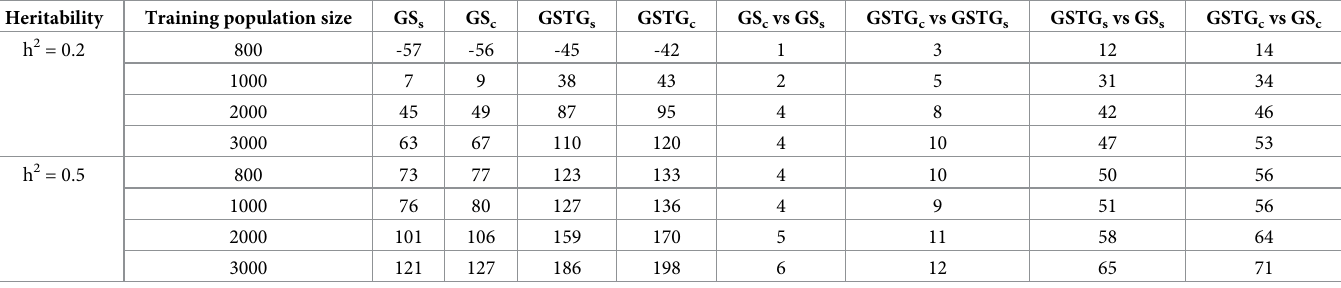
Table 7. Additional genetic gains (percentage) across 8 rotations obtained from deploying genetic material selected from GS over a baseline of deploying progeny of the selected individuals from FS (FS s ) for different deployment options: Deploying progeny (seedlings) of the individuals selected from GS (GS s ), deploying clones of the individuals selected from GS (GS c ), deploying progeny of the individuals selected through GSTG (GSTG s ) or deploying clones of the individuals selected through GSTG (GSTG c